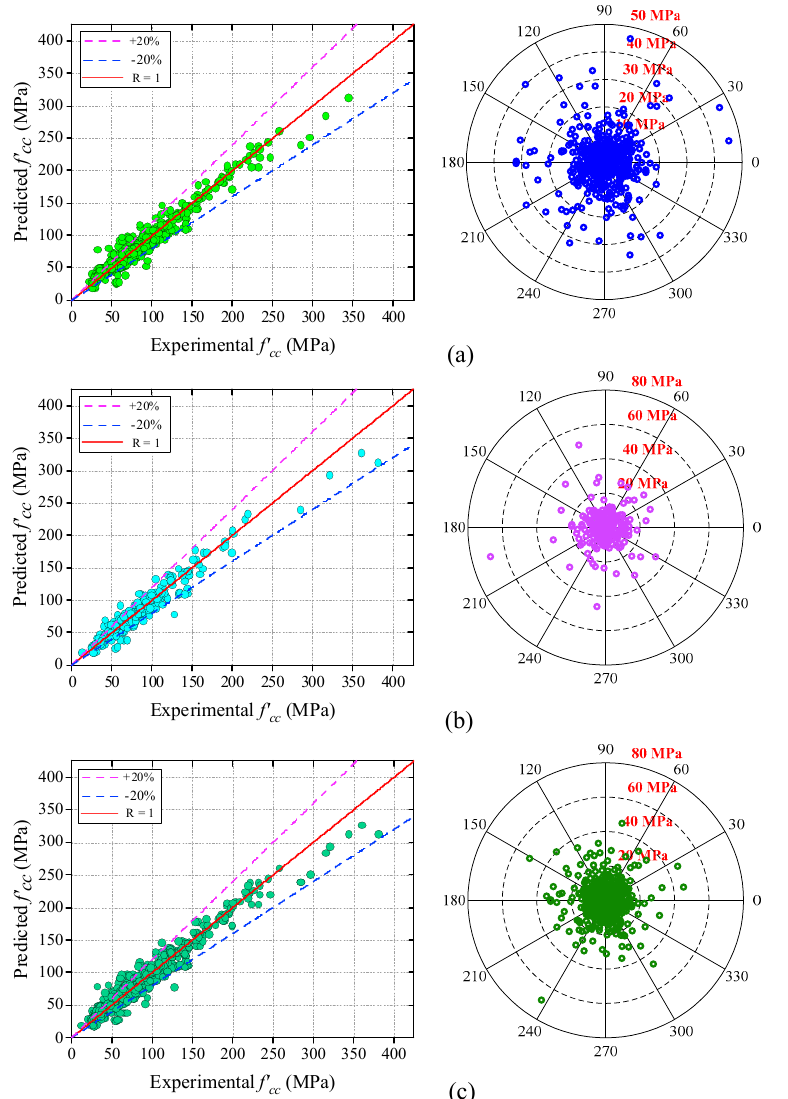
Figure 12. Scatter and absolute error plot of optimized SVM model; ( a ) training, ( b ) testing, and ( c ) whole datasets.